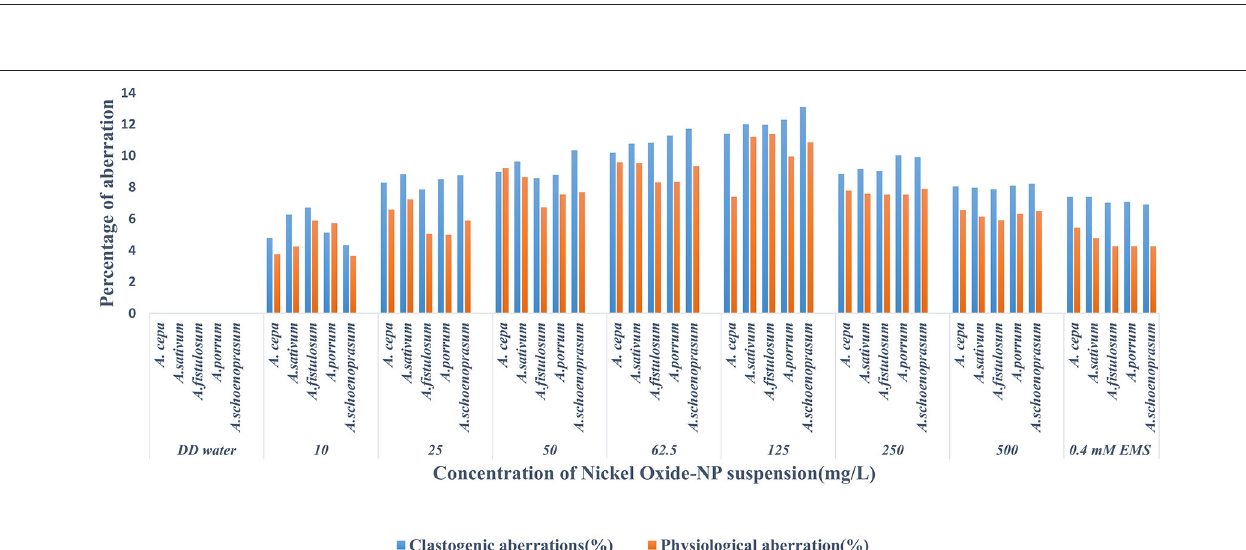
FIGURE 7 | Cells approaching pyknosis: (A) condensation of nuclear matter at a corner of the cell in A. porrum at 250mg L − 1 of NiO-NP suspension; (B) condensed nucleus in A. sativum at 250mg L − 1 of NiO-NP suspension; (C) fragmentation and condensation of nucleus in A. cepa at 500mg L − 1 of NiO-NP suspension;